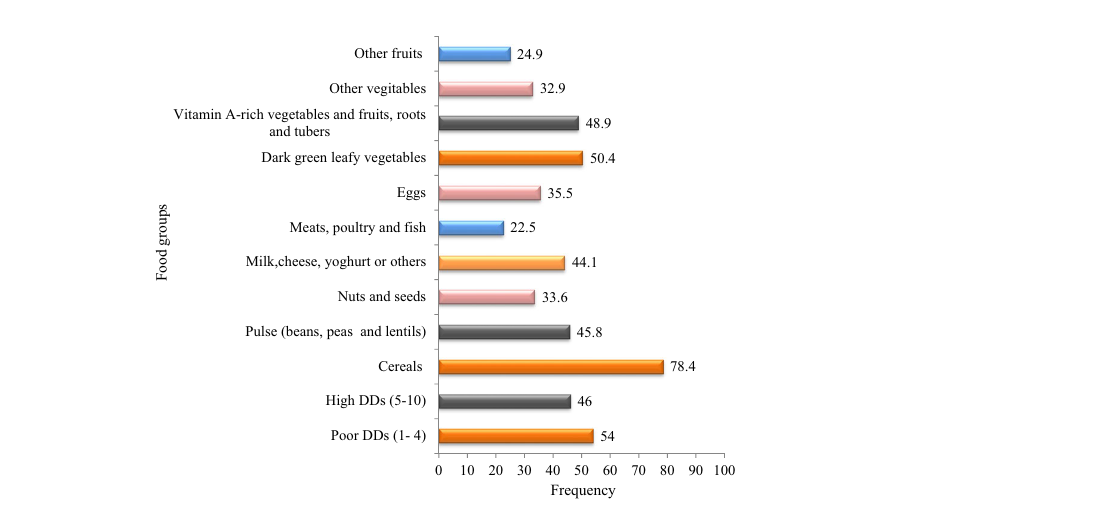
Figure 1. Dietary diversity score of pregnant women who ate each food type at least once a day in Kellem Wellega zone, western